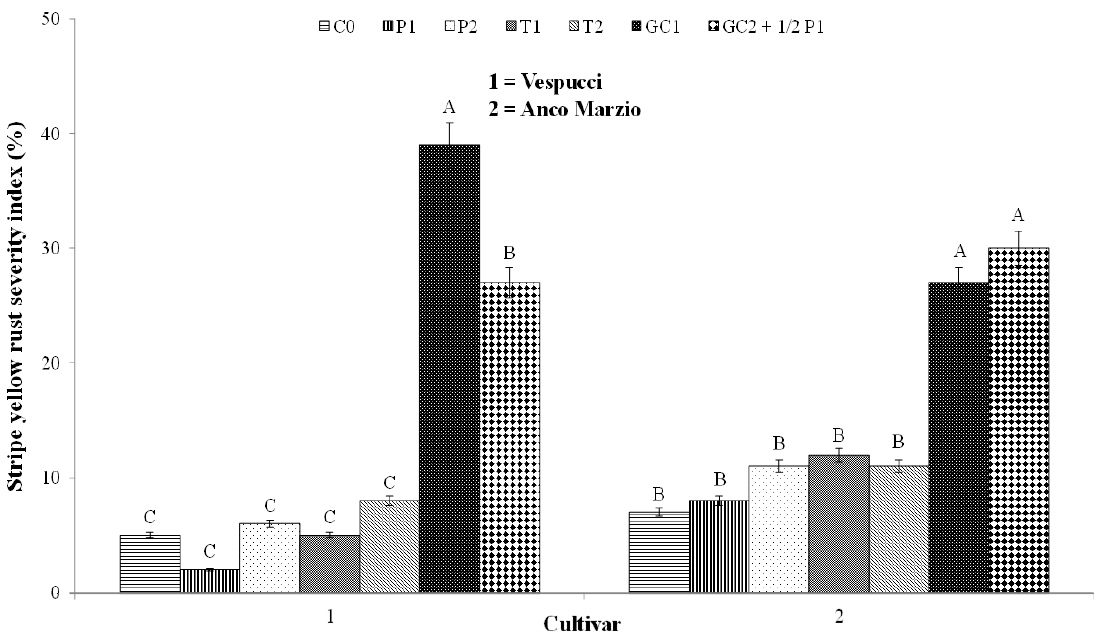
Figure 3. Stripe yellow rust severity in two durum wheat cultivars (Vespucci and Anco Marzio) naturally infected by Puccinia striiformis Westend. f. sp. tritici Erikss. (Pst) under different fertilization regimes during the second year of the crop cycle. Data are means of three replicates (10 leaves for each) where different letters between cultivars indicate different severity to Pst according to the SNK test at the p = 0.01 level. Bar indicates the standard error of the mean (n = 3). Table 2. Means of chlorophyll content (SPAD index) in the years 2019/2020 and 2020/2021 observed at stem elongation, booting, ear emergence, and kernel ripening phases in two durum wheat cultivars. Fertilization